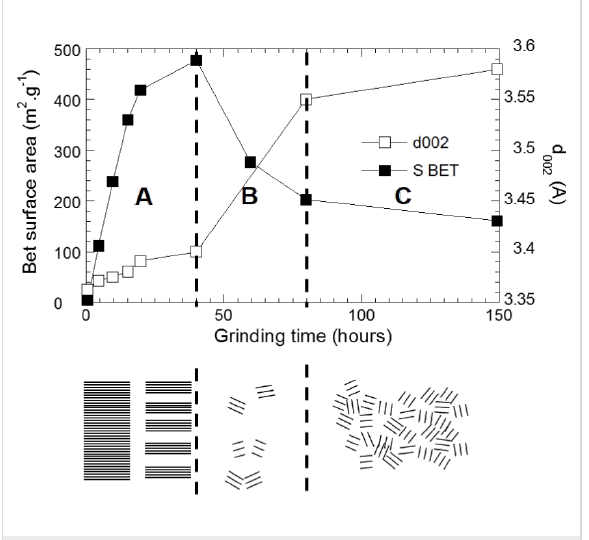
Figure 15: Graphite BET surface area (m 2 ·g − 1 ) and d (002) interlayer distance (Å) as a function of grinding time (h) [11].